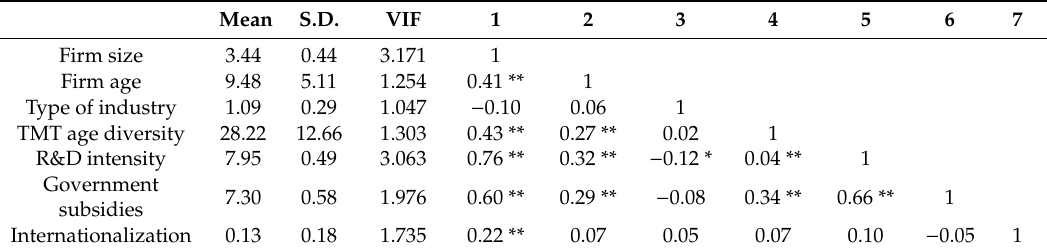
Table 1. Descriptive statistics and Pearson correlation matrix (n = 274).